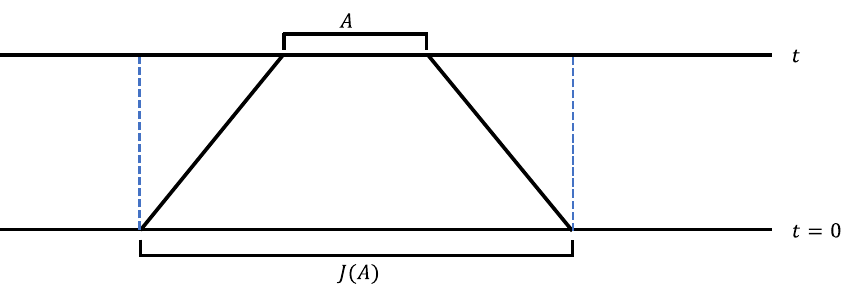
FIG. 8. Causal constraints and subre- gion thermalization. To find the entan- glement entropies of A in a system with a sharp light-cone structure, it is sufficient to consider the part of the time-evolution operator in J ( A ) , that is, between the dashed